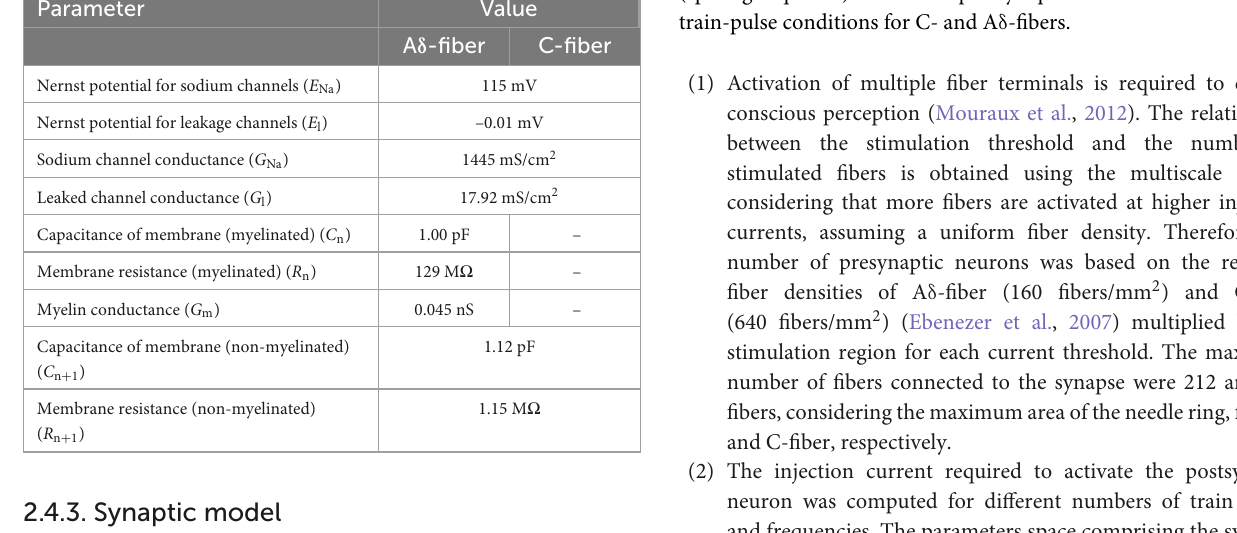
TABLE 1 Electrical parameters of myelinated and non-myelinated nerves.